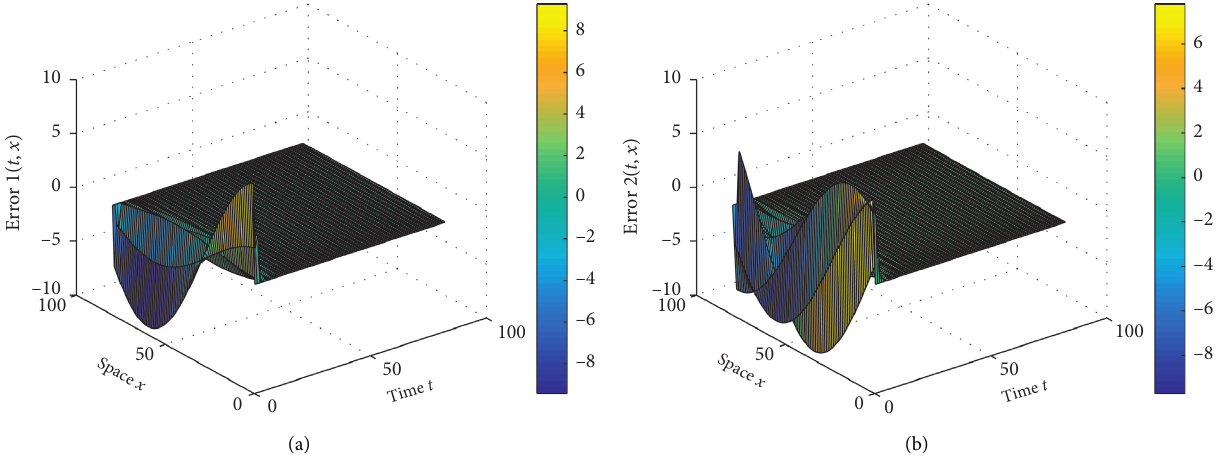
Figure 2: Synchronization errors between systems (24) and (25), under controller (30).